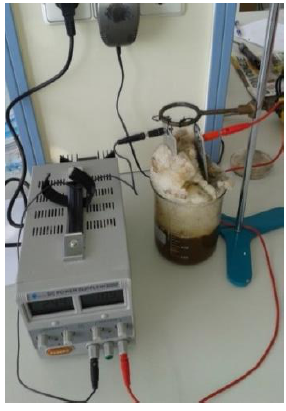
Figure 2. Foam formed